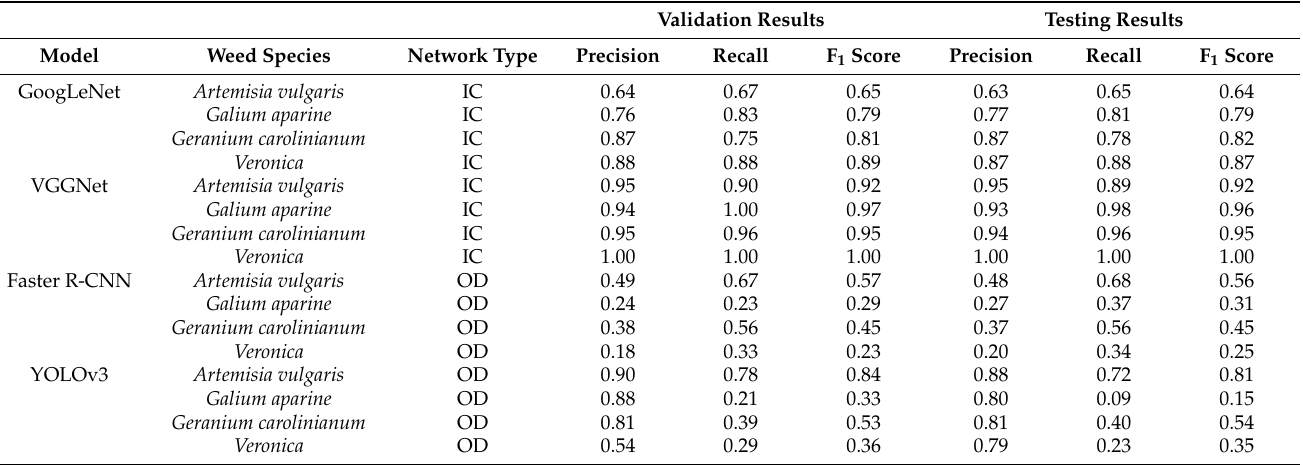
Table 4. The validation and testing results using image classification and object detection neural networks to detect broadleaf weeds growing in alfalfa a,b .